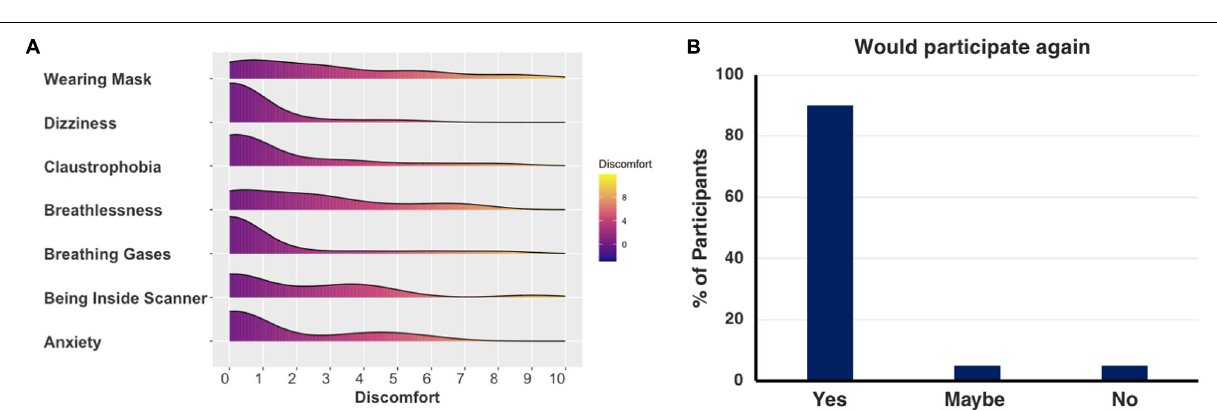
FIGURE 4 | Tolerability of the CO 2 -CVR scan. Plots show responses from 21 participants of the Heart and Brain Study stating (A) the level of discomfort (rated from 0 to 10) related to the different symptoms during a 5% CO 2 challenge and (B) the willingness to participate in a similar respiratory-calibrated MRI study again. Responses suggest that a 6-minute respiratory paradigm with a 5% CO 2 challenge is generally well-tolerated and feasible in older